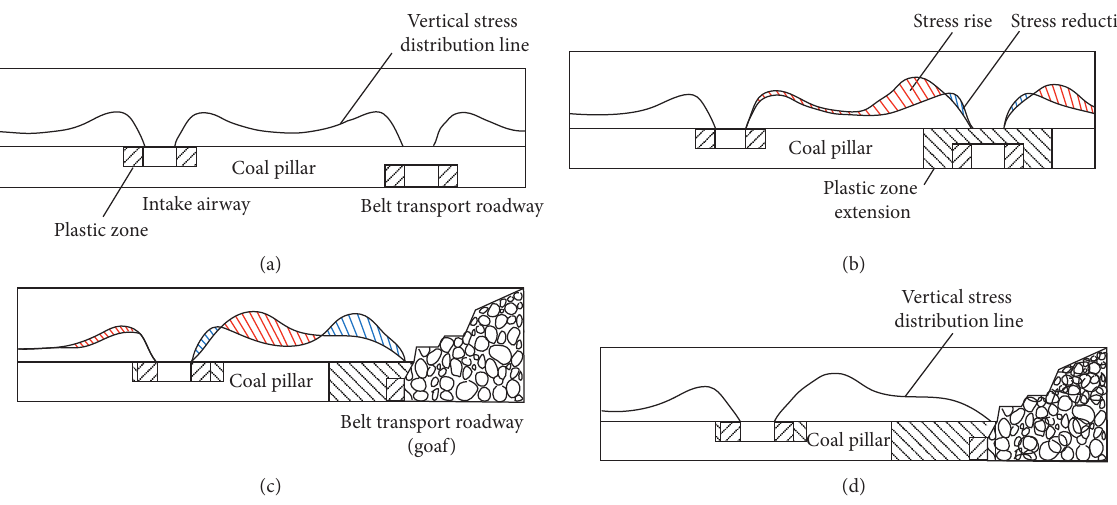
Figure 10: Characteristics of elastoplastic transformation and stress evolution “dip” stage of